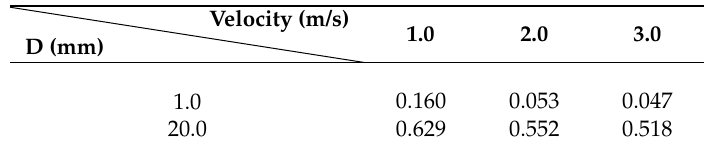
Table 6. Sedimentation results for soil of diameter 1.0 mm according to changes in inlet velocity (where the soil deposition rate h/D).